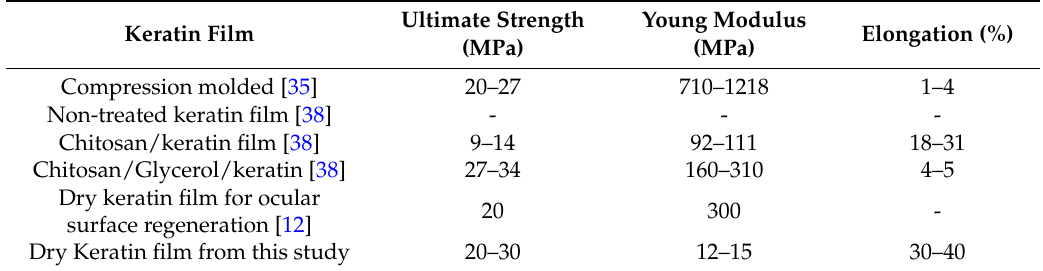
Table 1. Mechanical properties of keratin film which have been reported in different studies.